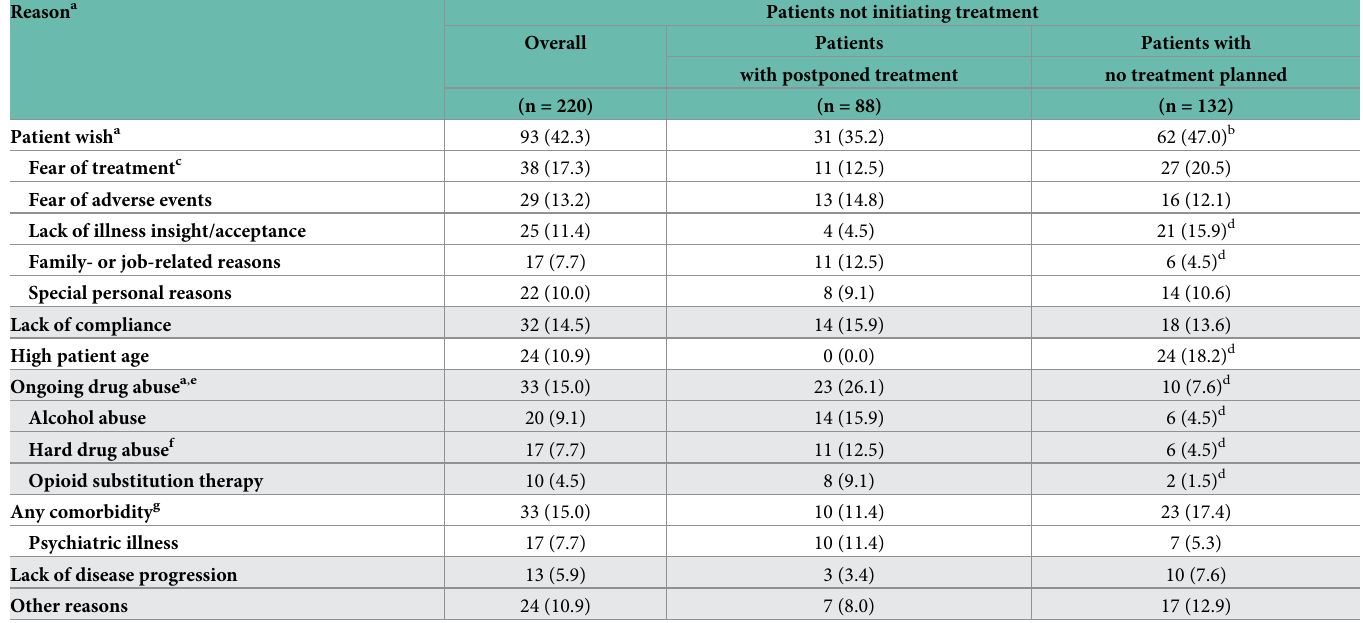
Table 3. Reasons reported for not initiating CHC treatment ( > 4% of